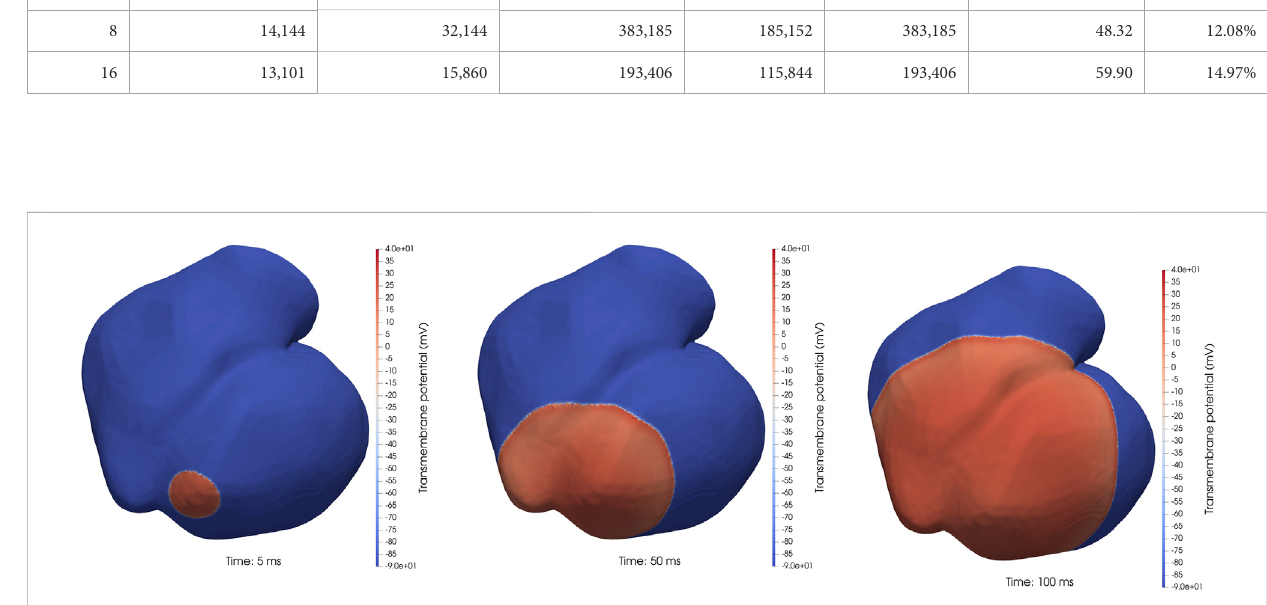
FIGURE 4 Three snapshots of the 3D transmembrane potential fi eld from a realistic monodomain simulation using the heart04